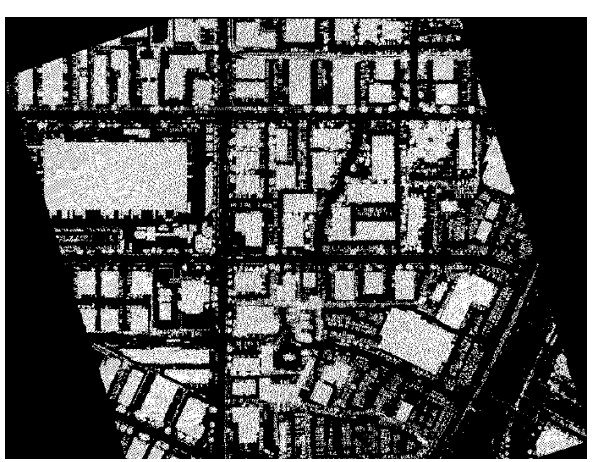
Figure 4. The extracted off-terrain points. This histogram is used to detect the intensity threshold value at which the DTM is either considered as grass or asphalt.